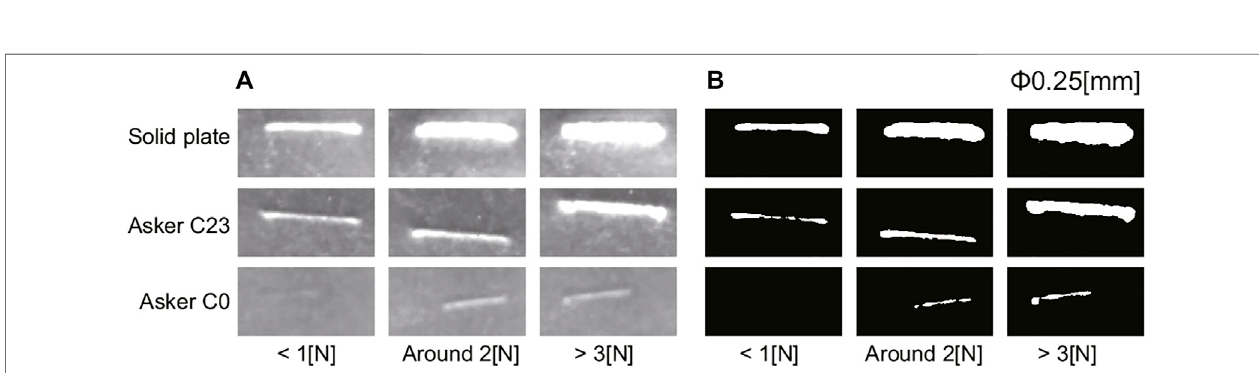
FIGURE 7 | Experimental results of hard object piece detection: Output image for ϕ 0.25 (mm) nylon thread piece. (A) raw image from the sensor, (B) binarized image. The area shown by white pixel is used as response of the sensor for each condition.